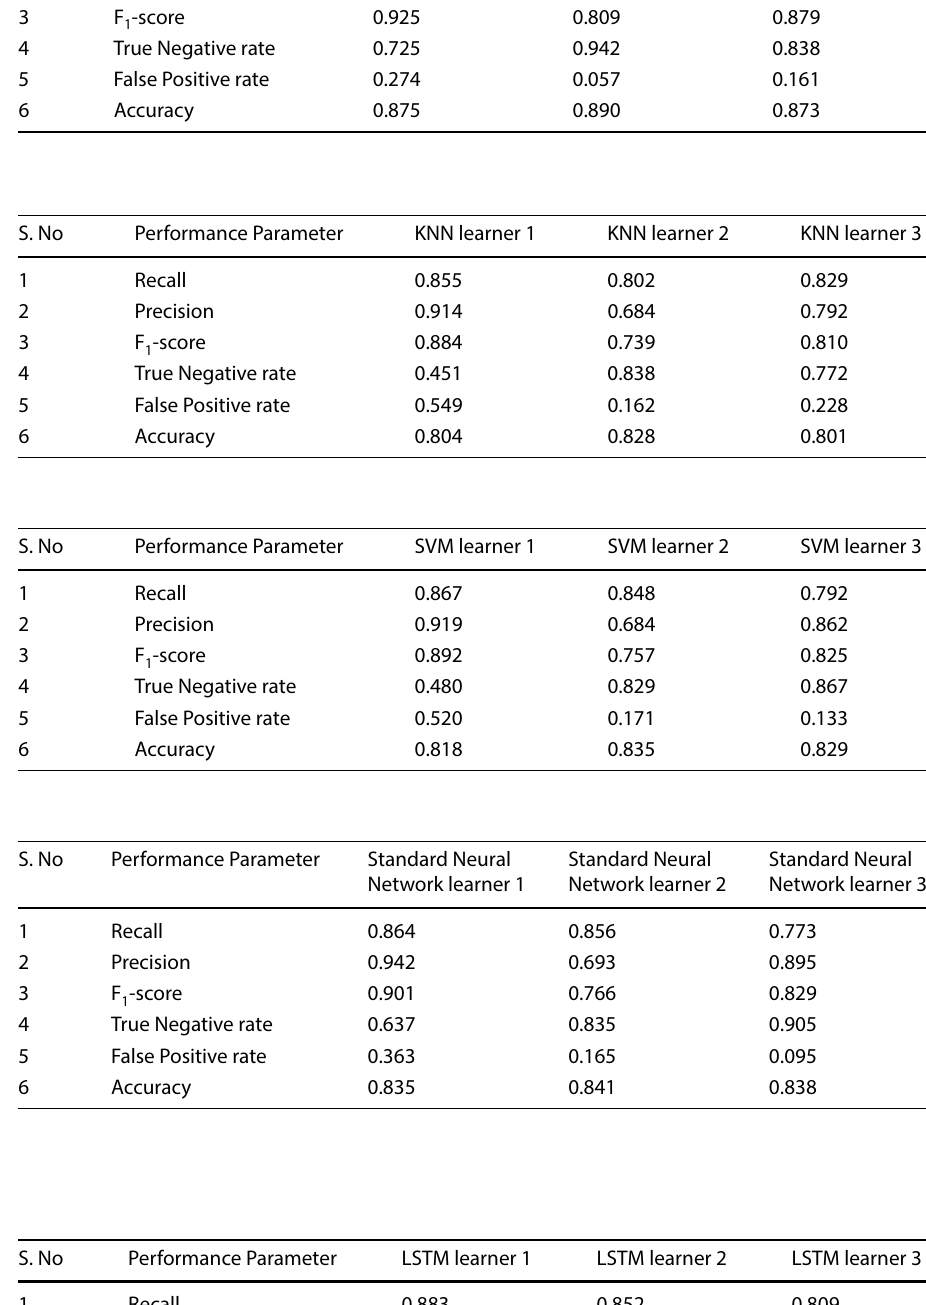
Table 9 Performance parameters of the LSTM